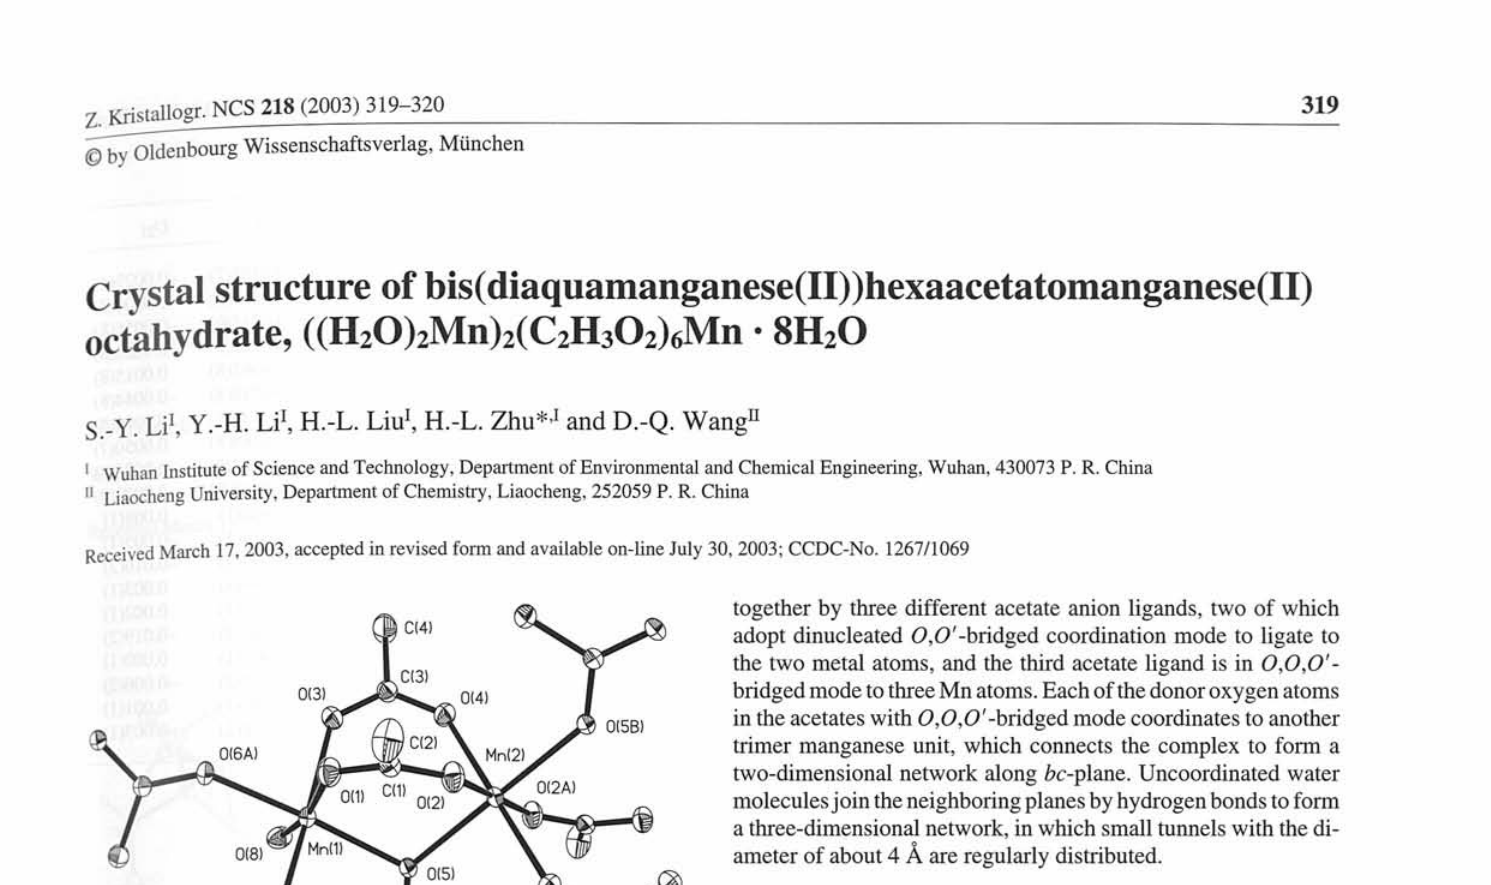
Table 1. Data collection and handling.